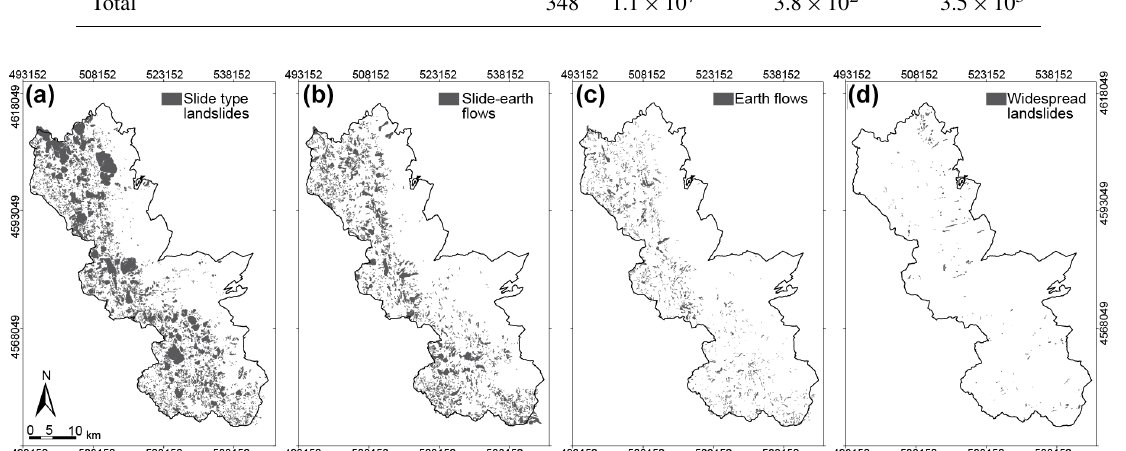
Figure 5. Spatial distribution of (a) slide-type landslides, (b) slide-earth flows, (c) earth flows, and (d) widespread landslides.